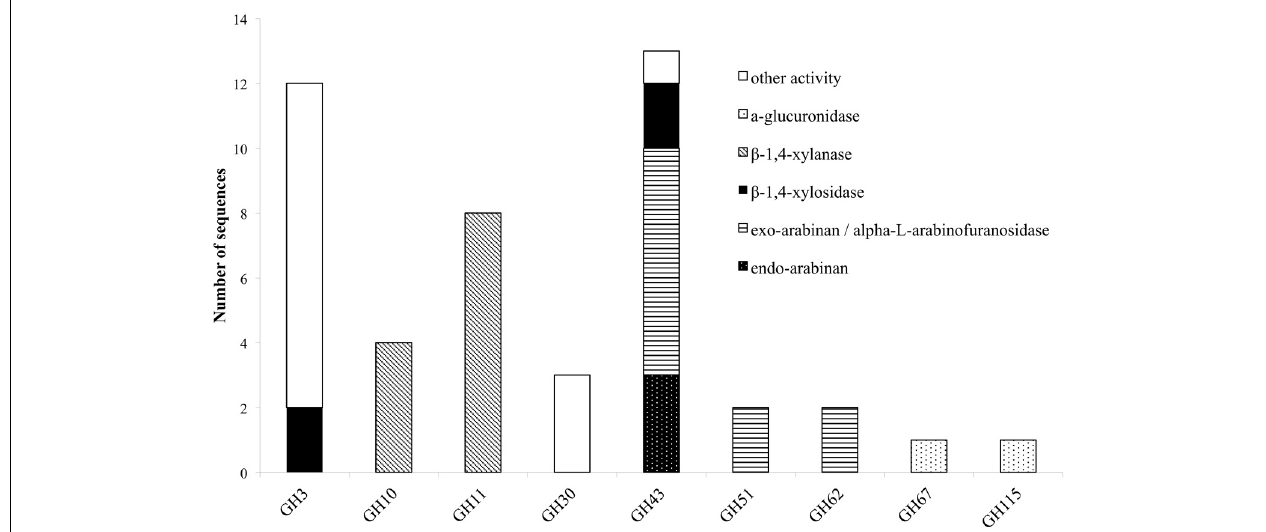
FIGURE 2 | Distribution of hemicellulolytic enzymes of M. thermophila throughout nine GH families. Other activities refer to β -glycosidase (GH3), xylanase with endo-exo mode of action and xylobiohyrolase (GH30), and galactan 1,3-beta-galactosidase (GH43).